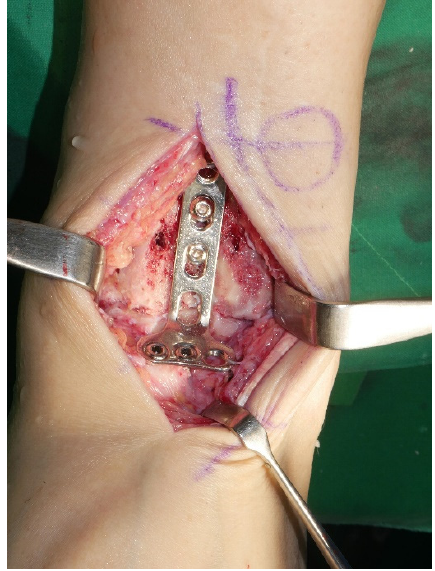
Figure 7. After screw fixation, additional anterior plating was performed through anterior incision.